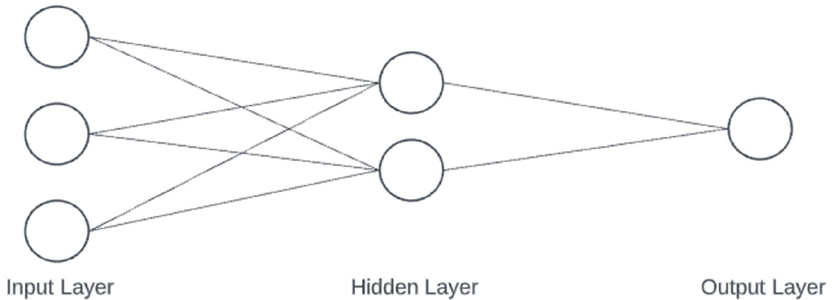
Figure 4. Feed forward neural network architecture .